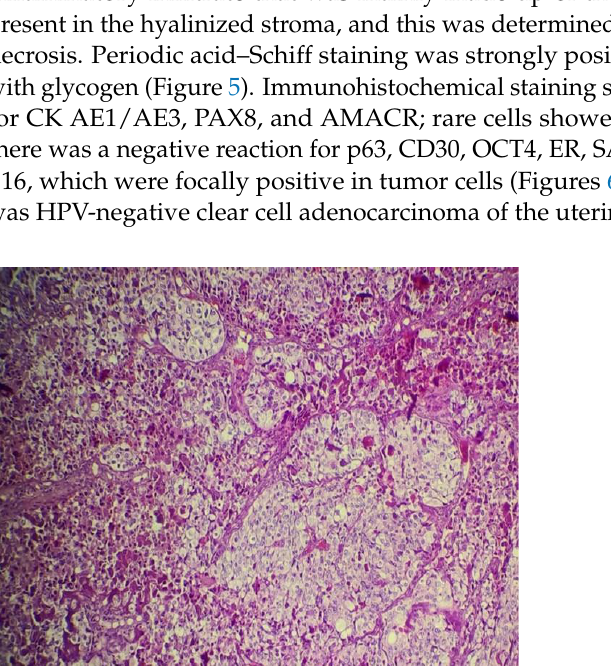
Figure 3. Tubulocystic pattern of tumor cells with clear cytoplasm, inflammatory infiltrate, necrosis, and hemorrhagic areas (HE ×100). Figure 4. Tumor nests with large neoplastic cells with prominent cell borders, ovoid nuclei, clear cytoplasm, and stromal hyalinization (HE ×100).